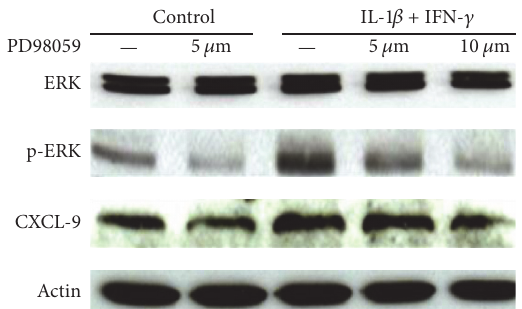
Figure 3: IL-1 𝛽 and IFN- 𝛾 effects are mediated via ERK sig- nalling pathway. Immunoblotting analysis of human muscle cells (CCL136) exposed to IL-1 𝛽 and IFN- 𝛾 and simultaneously treated with increasing concentrations of the p42/44 (ERK) MAP kinase inhibitor PD98059 for 24 hours. IL-1 𝛽 and IFN- 𝛾 led to increased phosphorylation of ERK. Treatment with the ERK inhibitor PD98059 resulted in a trend towards decreased protein levels of CXCL-9. One of two experiments with identical results is